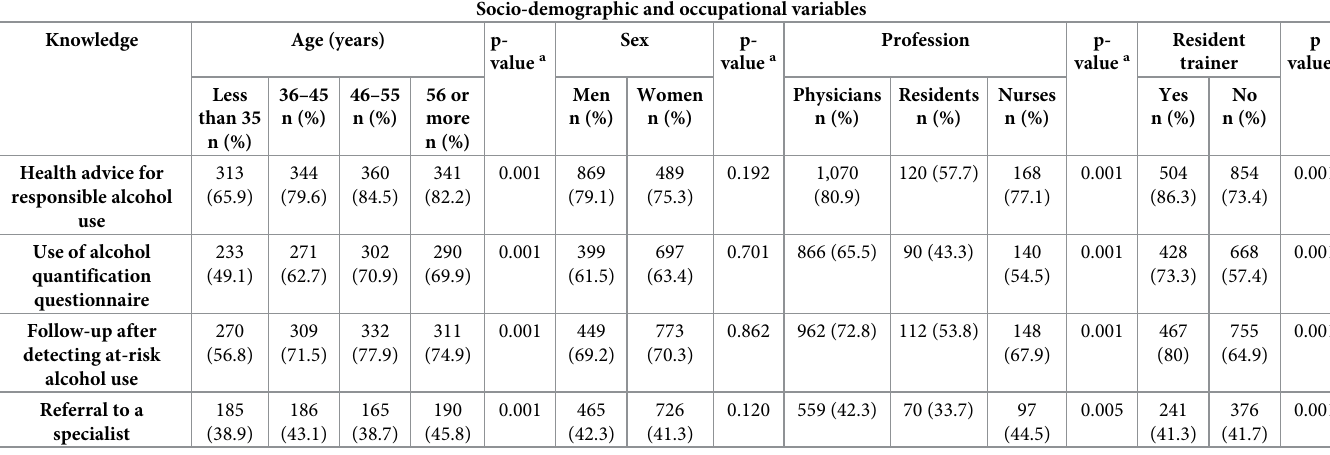
Table 2. Variables associated with the level of knowledge on the approach to alcohol consumption through multivariate analysis, adjusted for age, sex, and profession. Socio-demographic and occupational variables